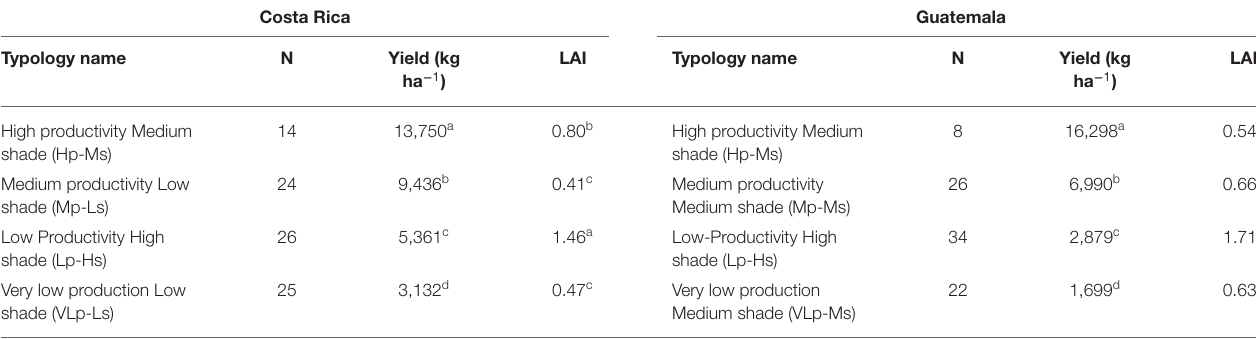
TABLE 2 | Coffee plantation typology groups according to productivity and LAI ( N = number of farms in the group). Costa Rica